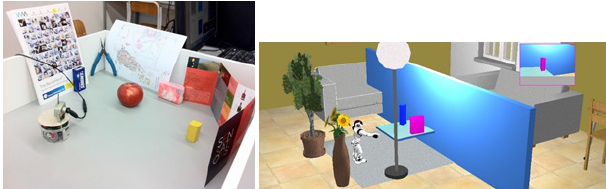
Figure 3: Experiment environments for E-Puck (Left) and NAO